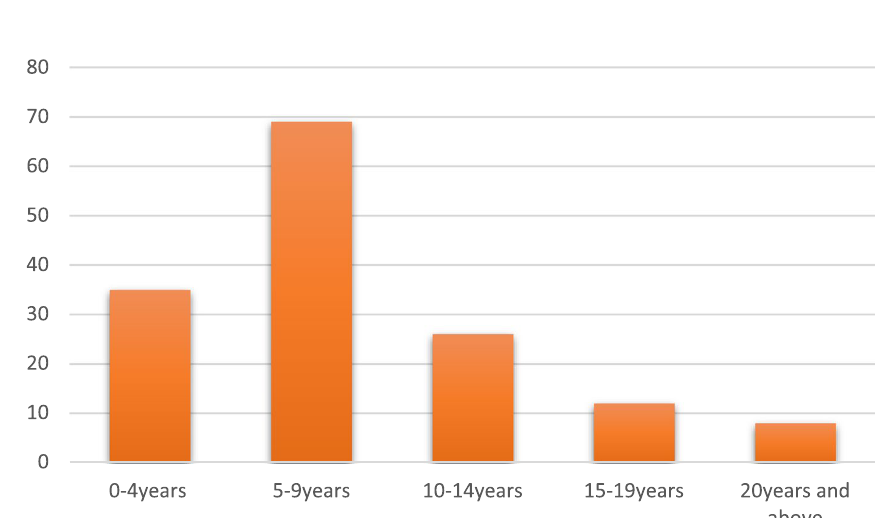
Fig. 5 Years of work experience of the